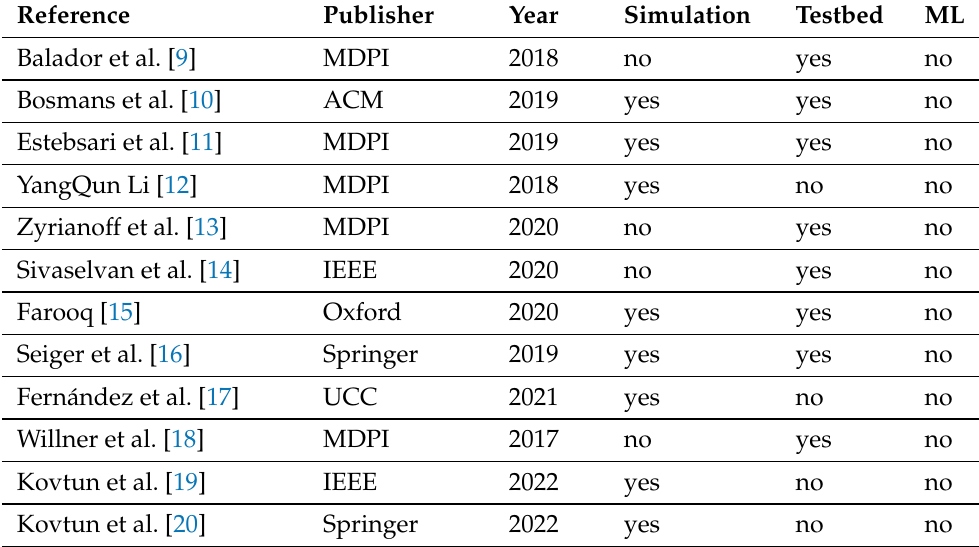
Table 1. Related works regarding IoT